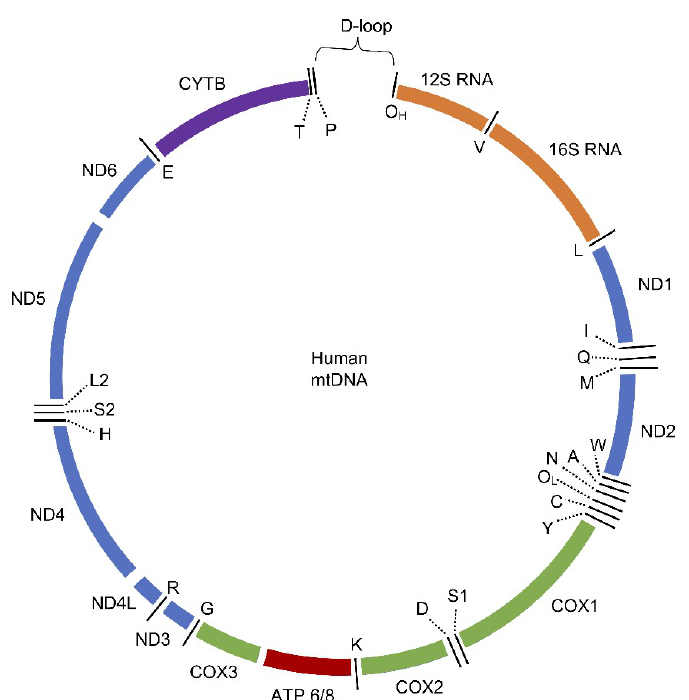
Figure 1. Schematic representation of human mitochondrial DNA (mtDNA). The circular molecule (16,569 bp) contains genes coding for 7 subunits of complex I (ND1–ND6, NADH ubiquinone oxidoreductase chain 1–6) (blue line), 1 subunit of complex III (CYTB, cytochrome B) (purple line), 3 subunits of complex IV (COX1–COX3, cyclooxygenase) (green line), and 2 subunits of complex V (ATP synthase 6 and 8) (red line). Moreover, mtDNA encodes 2 rRNAs (orange line) and 22 tRNAs for specific amino acids (marked with black lines with letter designation for specific amino acids) (based on [9]).